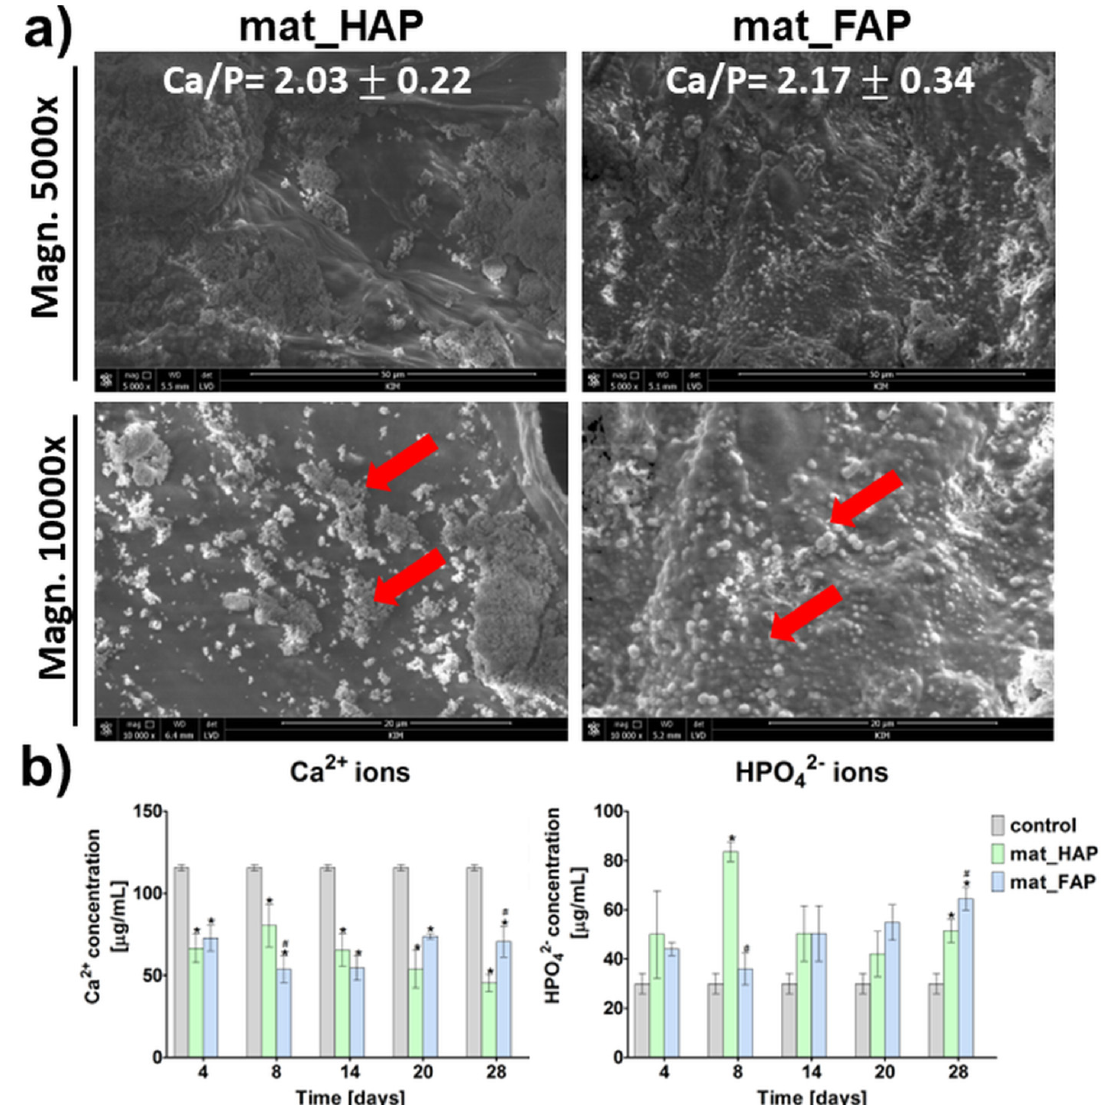
Figure 2. Apatite-forming ability of biomaterials: ( a ) SEM images of biomaterials’ surfaces after soaking in a simulated body fluid (SBF) for 28 days (red arrows indicate apatite crystals; Ca/P atomic ratio was calculated for apatite crystals), ( b ) changes in Ca 2+ and HPO 4 2 − concentrations in SBF, during incubation with biomaterials (* statistically significant results compared to control SBF; p < 0.05, unpaired t -test).